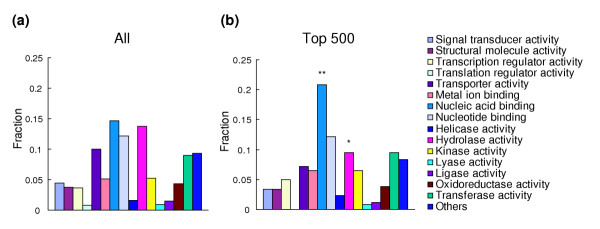
Categories of genes enriched in the sensory neuron fraction. Genes were categorized according to the GO molecular function categories. (a) Categorization of all the genes on the microarray; (b) categorization of genes within the top 500 che-2::PABP/acr-5::PABP ranks. In both panels, the fraction of genes in each category in respect of all annotated genes is shown.*P < 0.05; **P < 0.01 (binominal distribution).